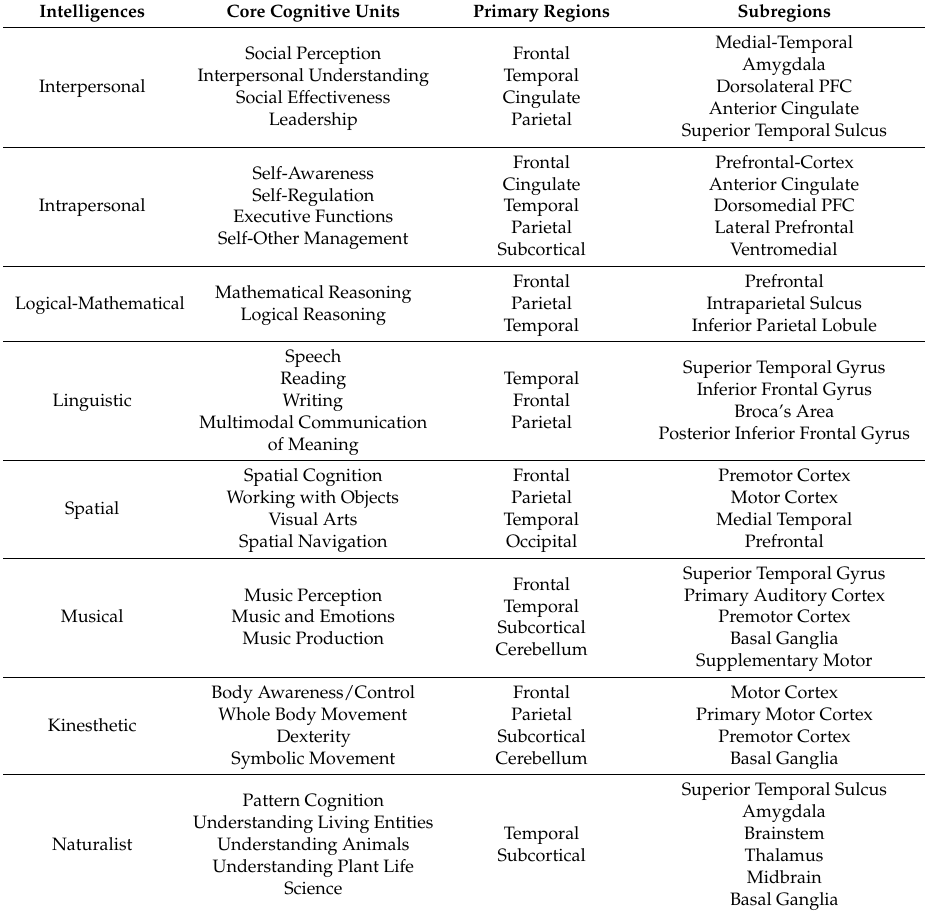
Table 1. Multiple intelligences core cognitive units and sample neural correlates